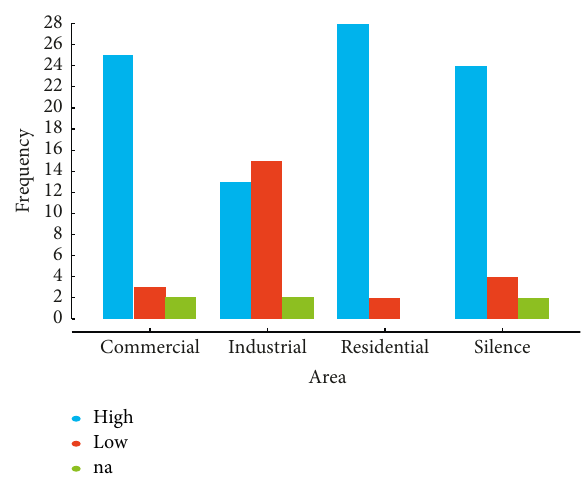
Figure 5: Area feature distribution in dataset generated by Orange tool with respect to noise feature.